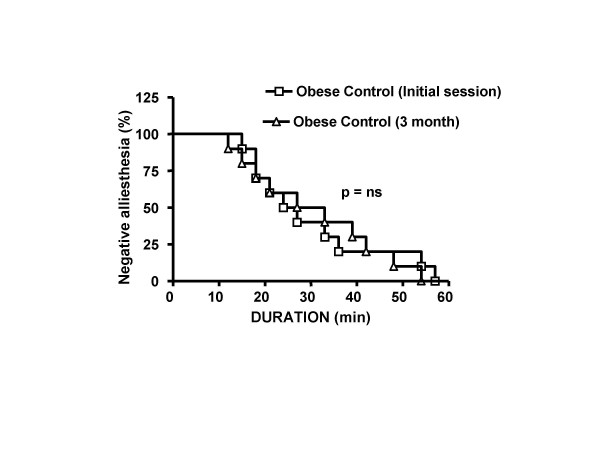
A Kaplan-Meier curve was created using historical control data obtained from morbidly obese patients (BMI > 50) awaiting bariatric surgery. Subjects did not receive any diet intervention. Participants all received the same test for negative alliesthesia described in the methods section. Both groups showed a similar satiety kinetic for sweet stimulus (Log-rank chi-square = 0.045, df = 1, p = 0.8311, NS). The median time to achieve satiety in both groups were comparable (Initial session 25.5 min vs. 3 month 30 min). These results suggest the test is reproducible in a clinical setting for patients.